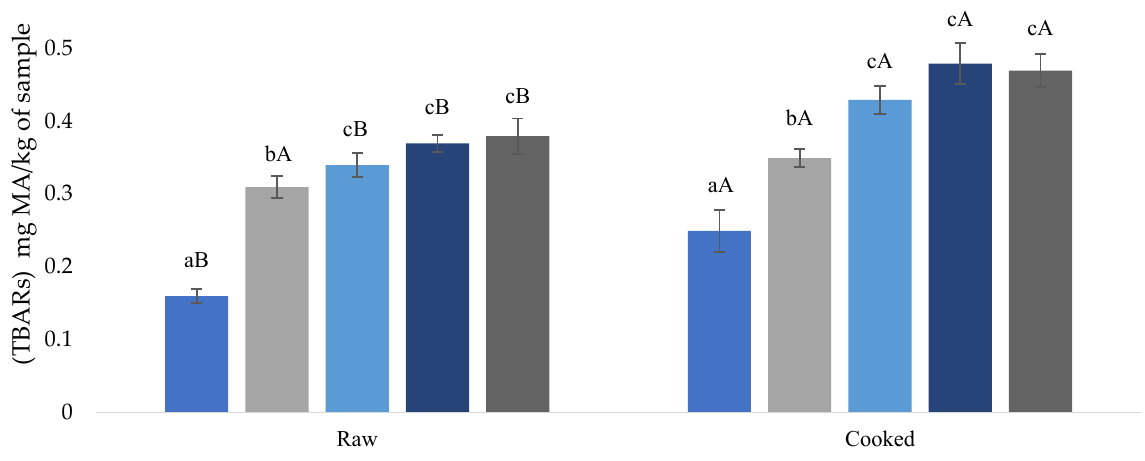
Figure 2. Effect of partial substitution of pork backfat with a gelled emulsion of maca flour, soybean oil, and chincho essential oil on the TBARs values of cooked beef burger. For each thermal treatment (raw or cooked), bars with different small letters indicate the existence of significant differences ( p < 0.05) among samples (BC, BSM, BSM0.25; BSM0.5, and BSM1.0) according to Tukey’s HSD post-hoc test. For each sample (BC, BSM, BSM0.25; BSM0.5, and BSM1.0), bars with different capital letters indicate the existence of significant differences ( p < 0.05) among thermal treatments (raw or cooked) according to Tukey’s HSD post-hoc test. PB: pork backfat; GE: gelled emulsion *BC: control burger with a traditional formula (20% PB); BSM: burger with 10% PB and 10% substituted by GE 1 with maca flour and soybean oil; BSMC0.25: burger with 10% PB and 10% substituted by GE 2 with maca flour, soybean oil, and chincho essential oil; BSMC0.5: burger with 10% PB and 10% substituted by GE 3 with maca flour, soybean oil, and chincho essential oil; BSMC1.0: burger with 10% of PB and 10% substituted by GE 4 with maca flour, soybean oil, and chincho essential oil. TBAR content had values ranging from 0.16 to 0.38 mg MDA/kg in raw